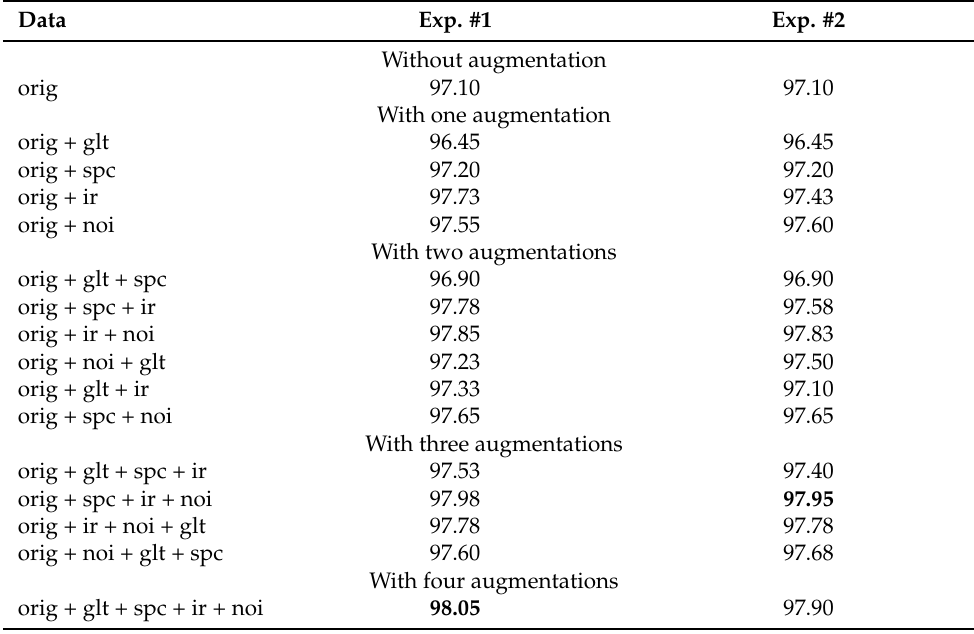
Table 2. Unweighted average recall (UAR, %) of SER with different data augmentation techniques on JTES-SI . orig = original JTES dataset, glt = glottal source extraction, spc = speech cleaned, ir = impulse response, noi = noise addition. The highest scores for each experiment are in bold.